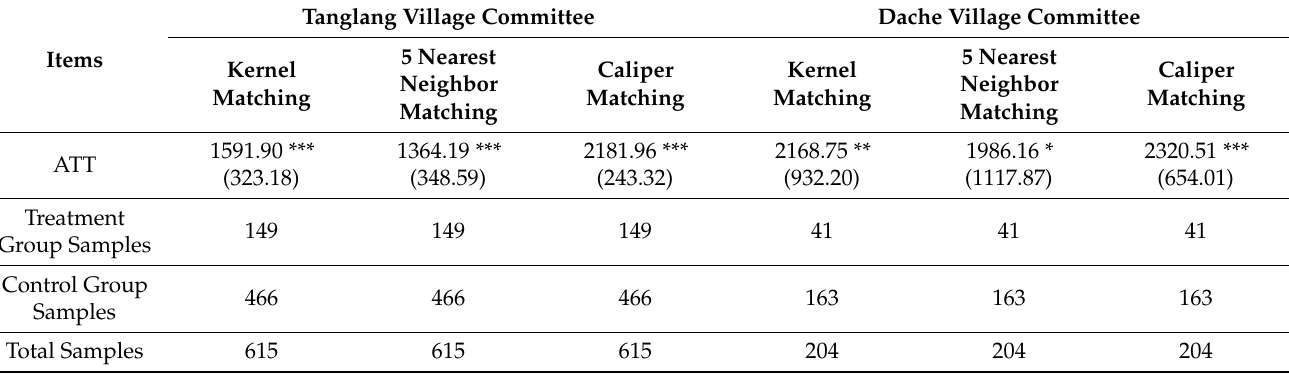
Table 9. Average Treatment Effect on the Treated (ATT) of Promoting Sorghum Planting Policy.